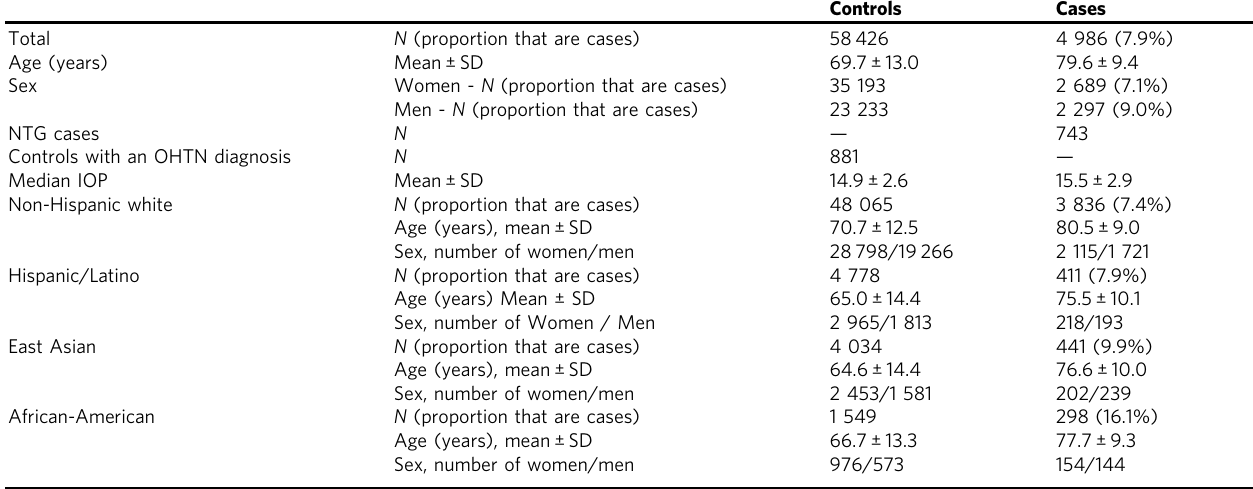
Table 1 Characteristics of the POAG cases and controls from GERA cohort